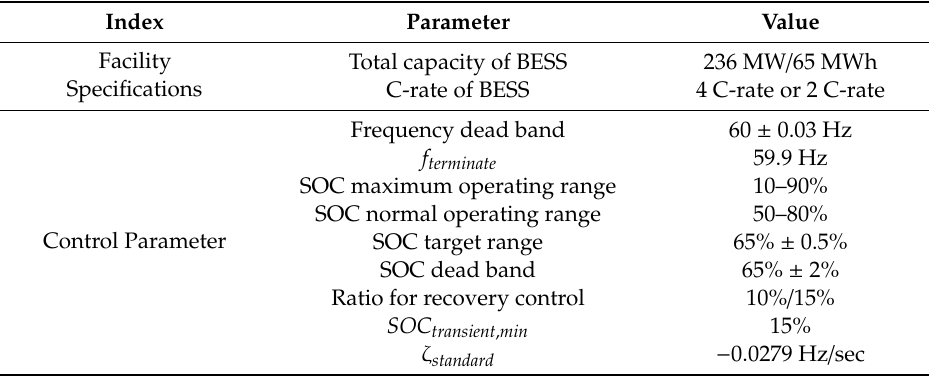
Table 4. Specifications for operating BESS.